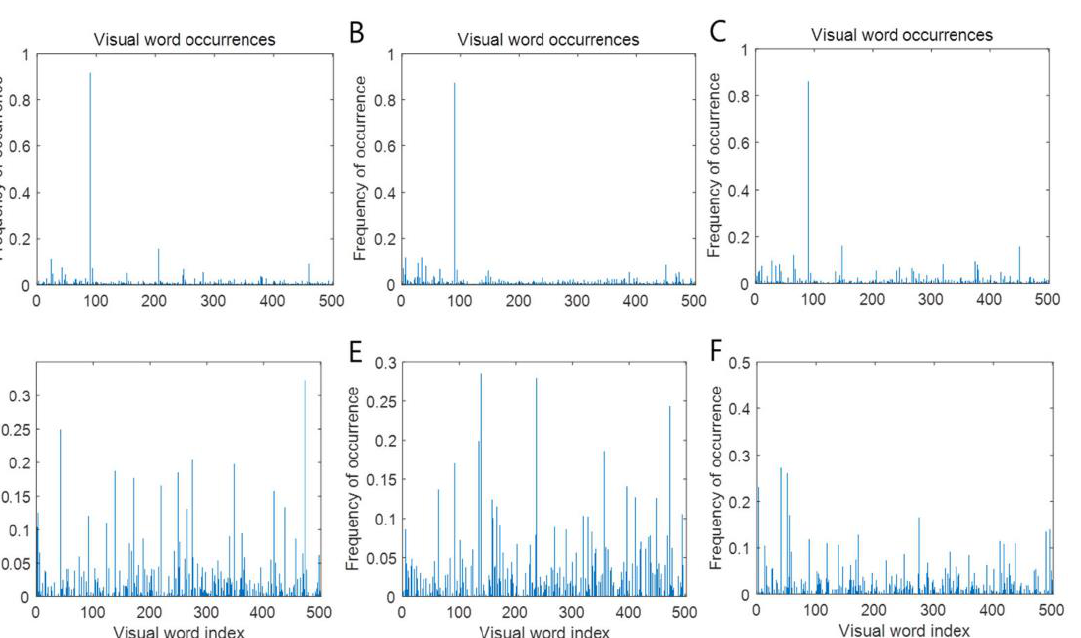
Table 1. Age and sex distribution of DITI data.